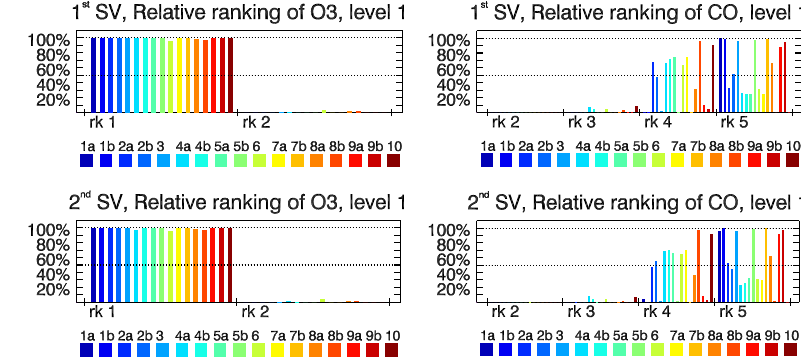
Figure 6. Relative ranking of the first (upper panel) and second (lower panel) singular vectors with respect to initial value uncertainties. Illustrated are results for O 3 (left panel column) and CO (right panel column) at surface level for all 17 case studies. Relative ranks are denoted below each bar plot. A rank m is only depicted if the associated chemical compound is ranked m th for at least one considered grid point. The colour coding of each case is denoted below each